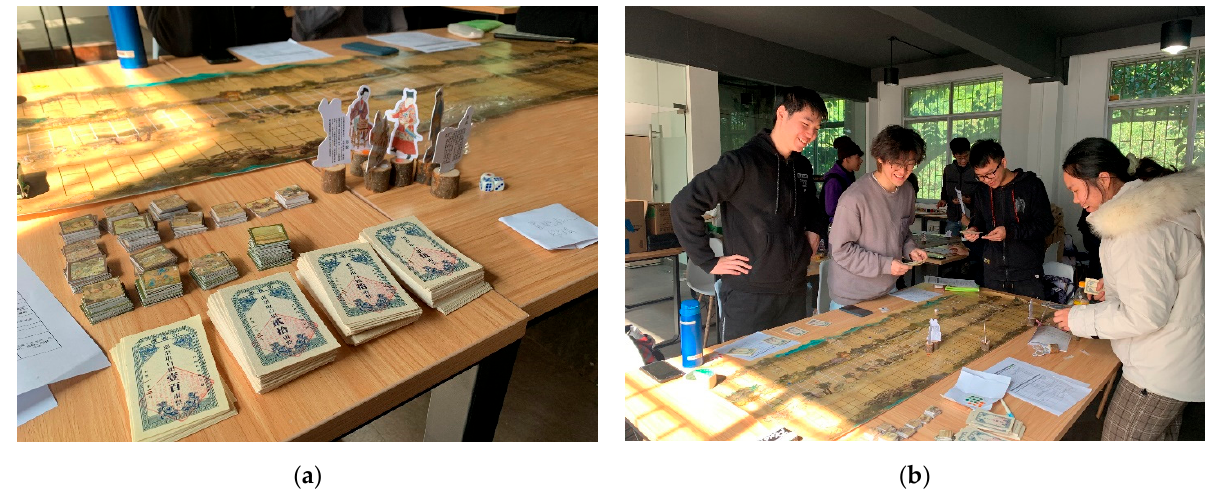
Figure 1. ( a ) The components of the serious game; ( b ) the game process.